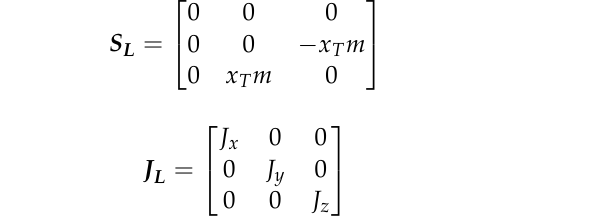
→ q represented by the → ϕ (8)